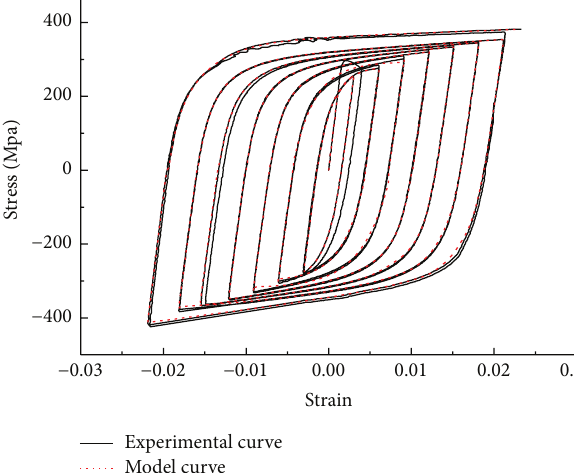
Figure 10: The specific description.